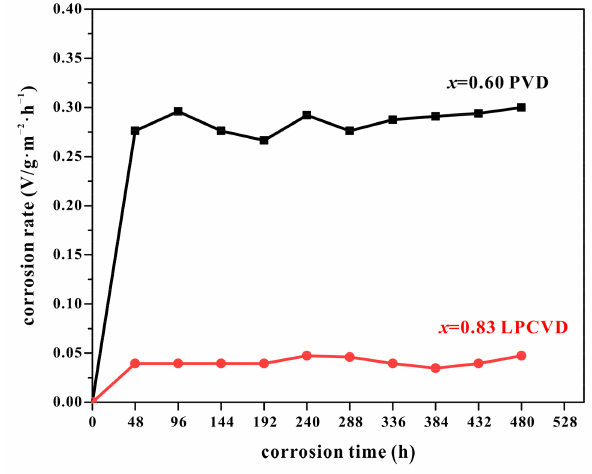
Figure 7. The corrosion rate of PVD-Ti 0.40 Al 0.60 N and LPCVD-Ti 0.17 Al 0.83 N coatings, as a function of